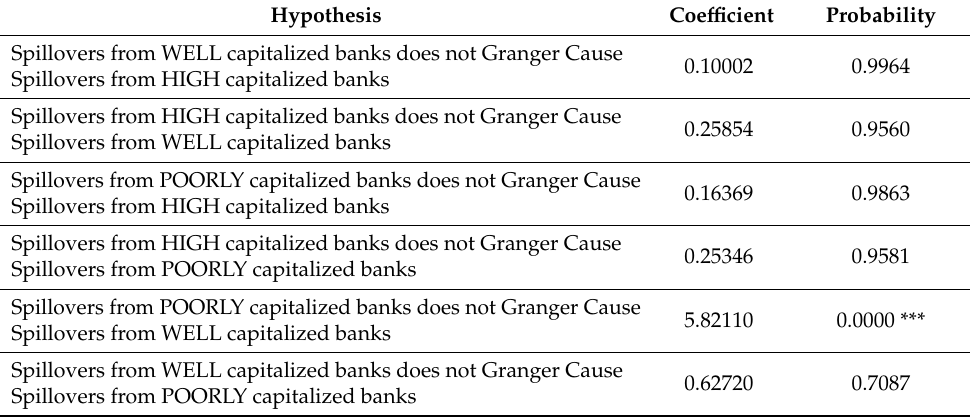
Table 6. Granger causality test for the size criterion, measured by market